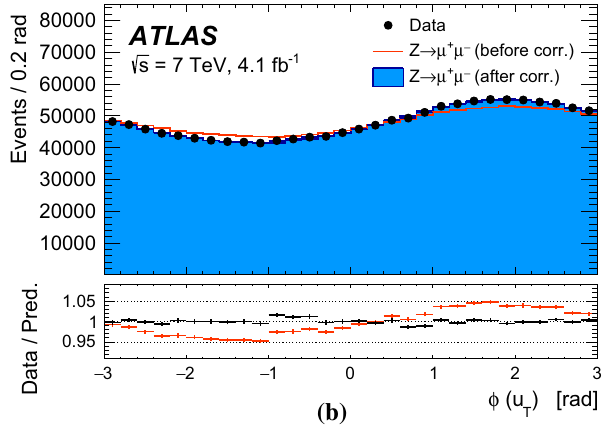
x , y correction. The lower